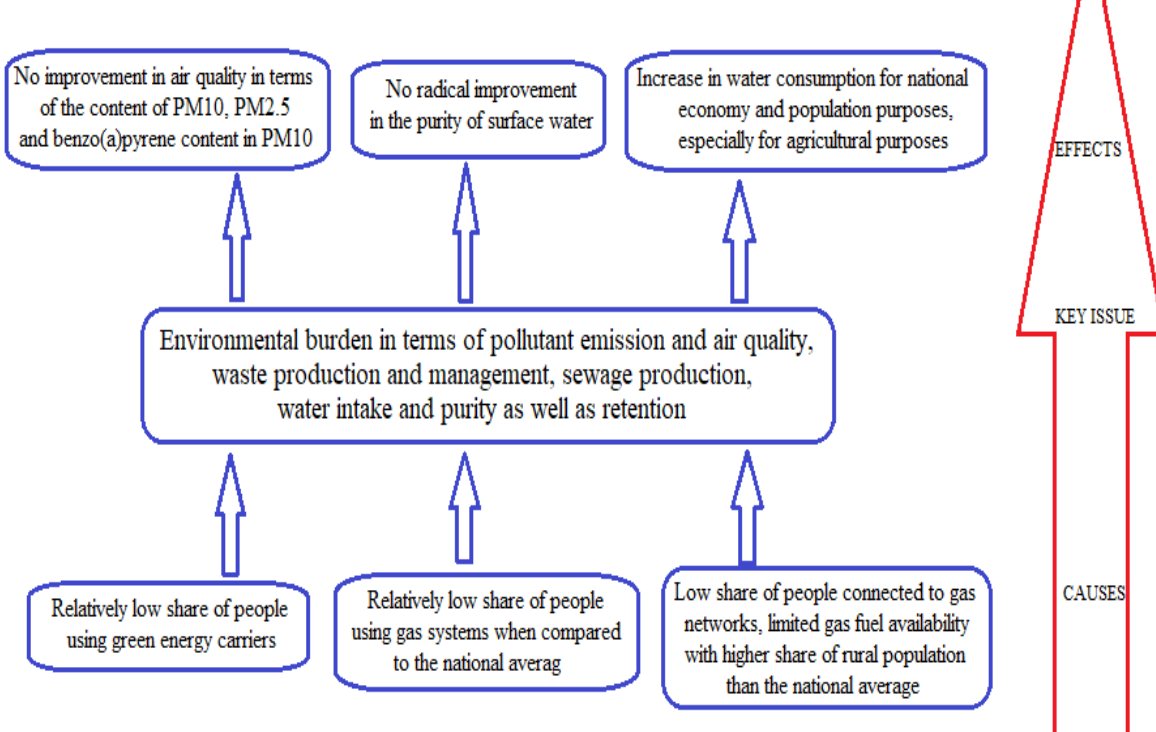
Figure 2. The “environment” issue tree. Source: Own elaboration.